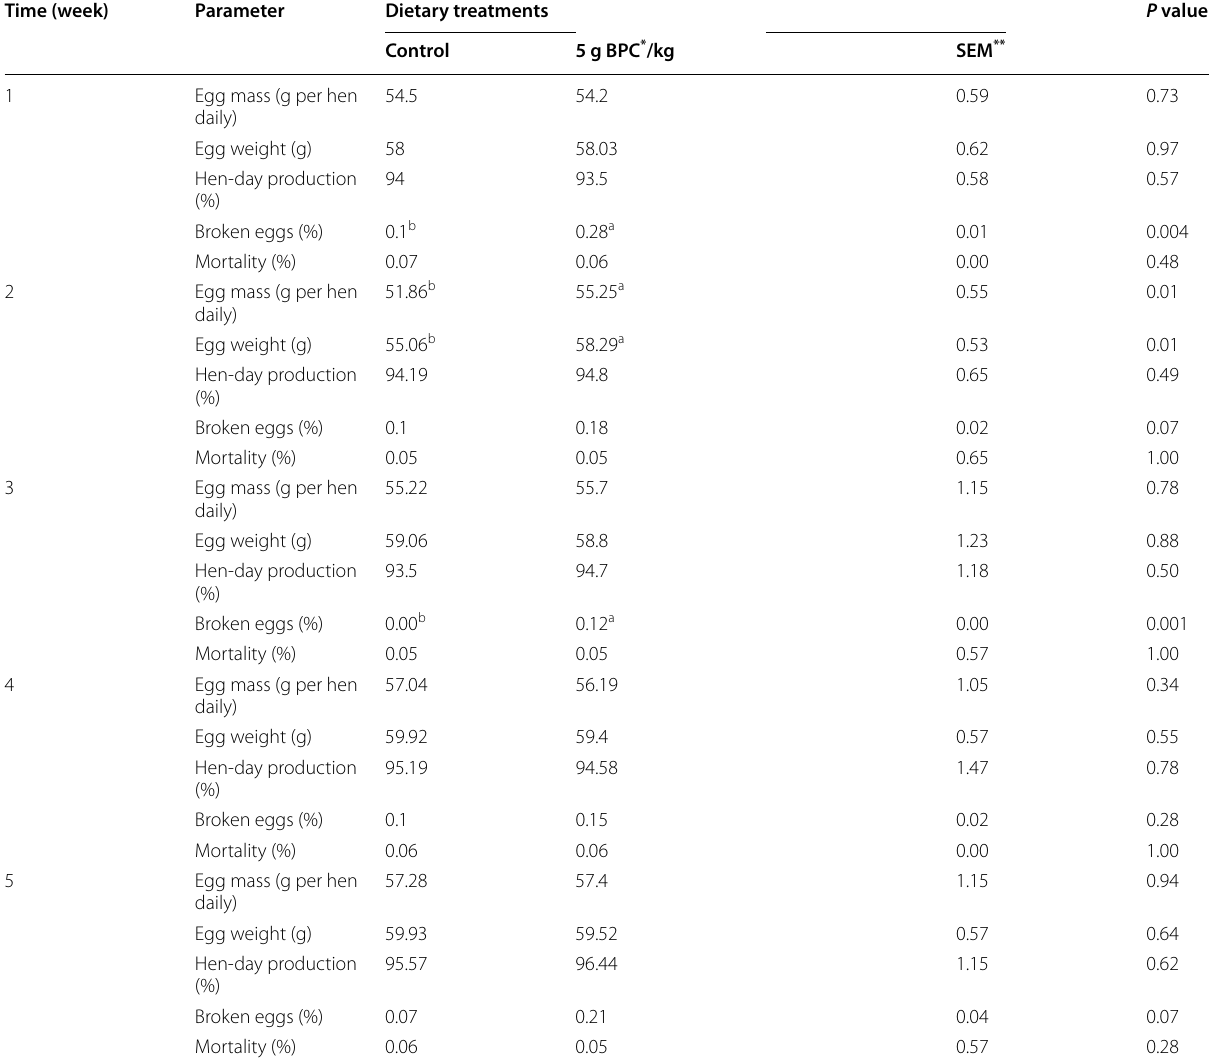
Table 3 Performance response to peptide supplementation in different